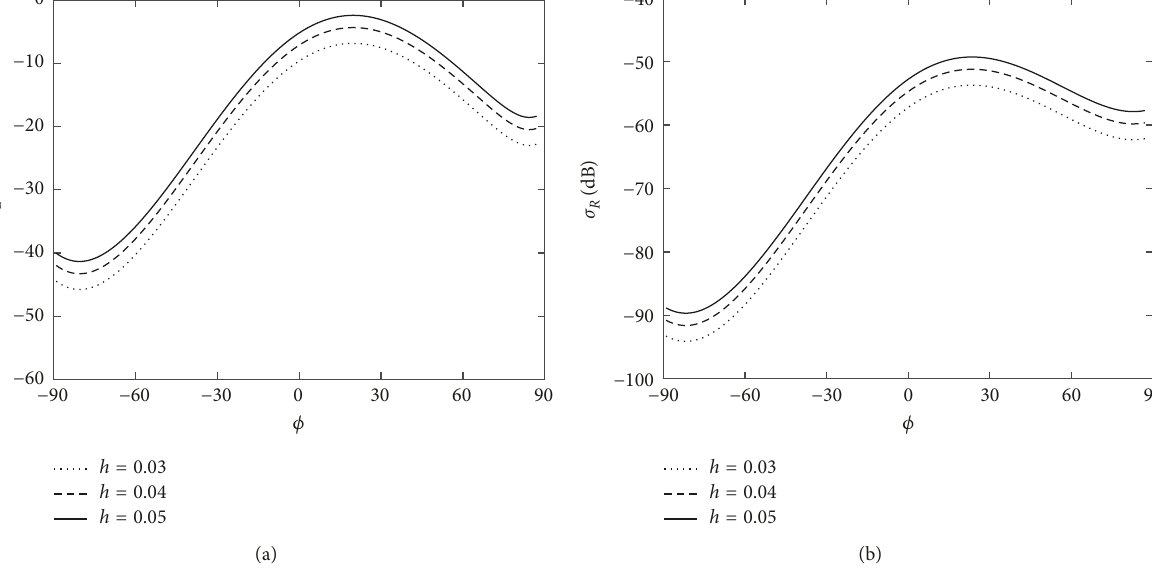
i (cid:31) 30 ° , ε r (cid:31) 4, β (cid:31) 0.03, and l c (cid:31) 0.35.